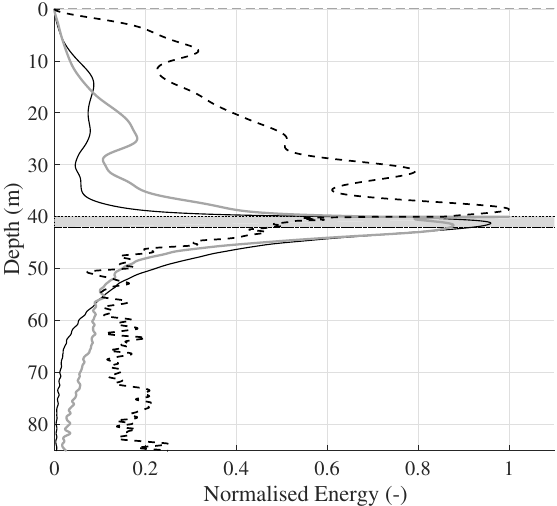
Figure 10. Energy flux at various distances from the pile as predicted using the model by Tsouvalas and Metrikine [115] for the BARD Offshore I wind farm case study. Thin black line: r = 20 m; thick grey line: r = 60 m; thick dashed line: r = 140 m. The light grey shaded area marks the thickness of the loose marine sediment layer (upper 2 m of soil in accordance with Table